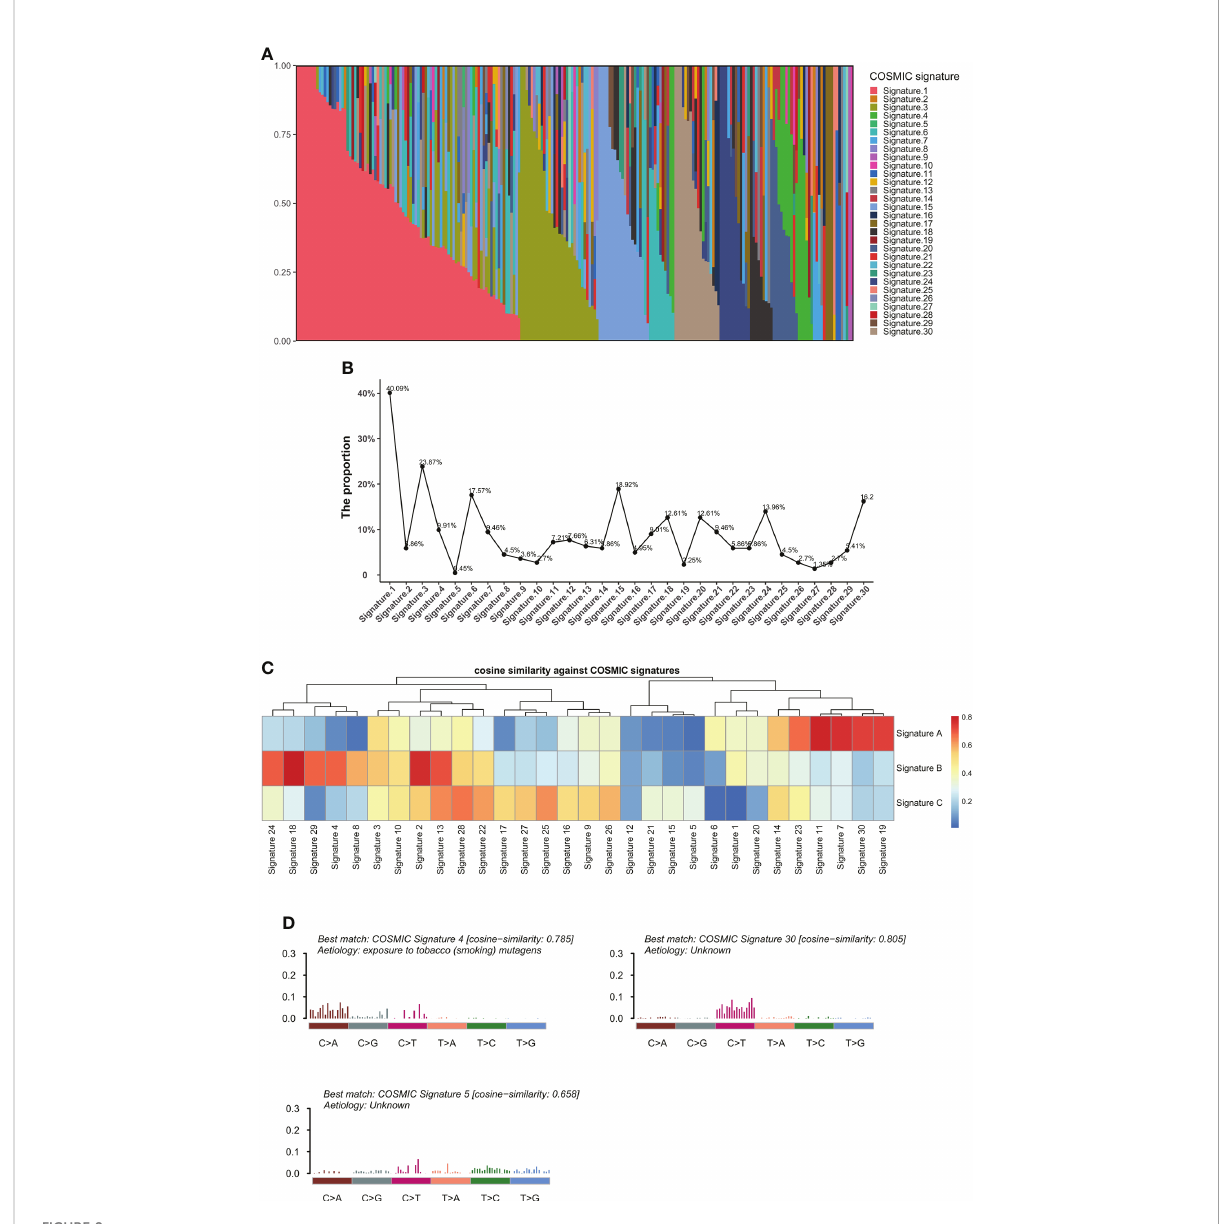
FIGURE 8 Analyses of mutational signatures in BTC patients. (A) Contribution of the 30 mutational signatures from the COSMIC among BTC patients. (B) The proportion of the 30 COSMIC mutational signatures in BTC patients. (C) Cosine similarities between three identi fi ed mutational signatures and COSMIC signatures. (D) Signature A, Signature B, and Signature C identi fi ed from BTC samples are linked to COSMIC Signature 4, Signature 30, and Signature 5, respectively. BTC, biliary tract cancer; COSMIC, Catalogue of Somatic Mutations in